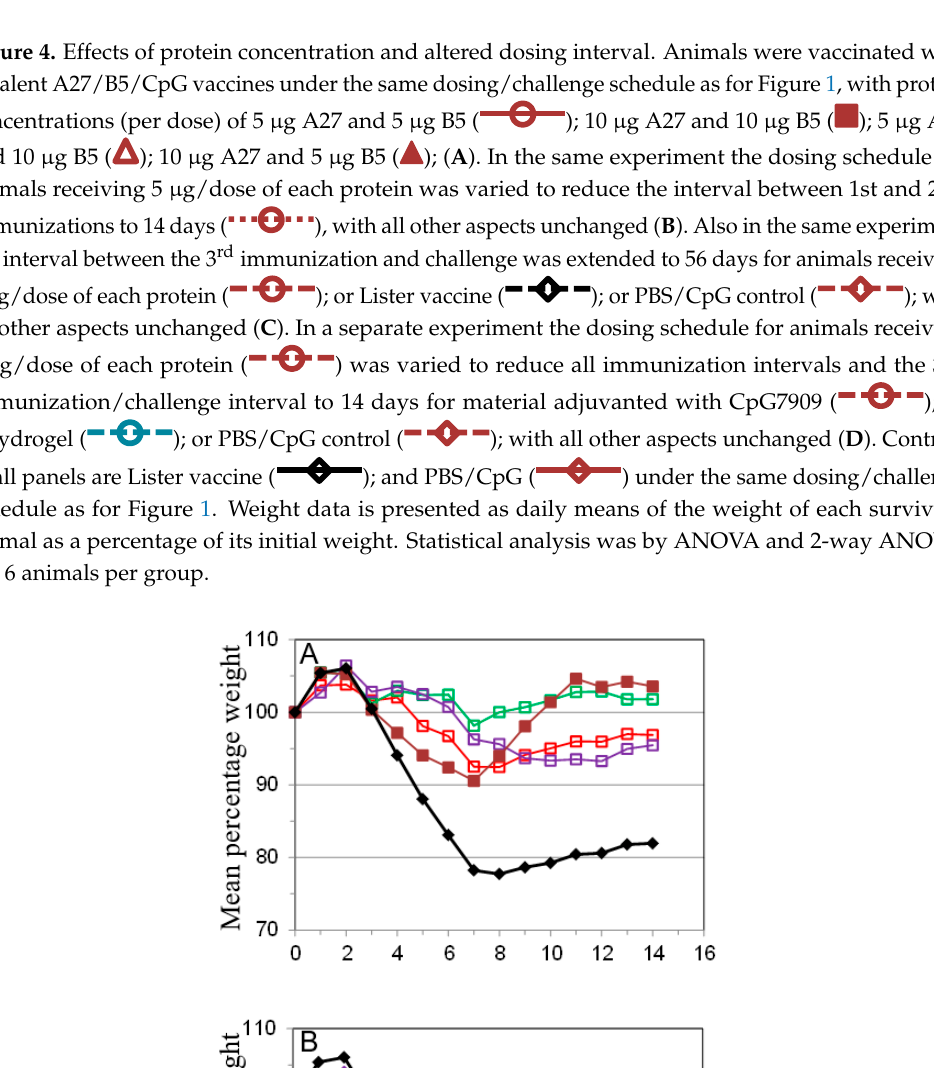
Figure 5. Effects of T cell subset depletion. Animals were vaccinated with PBS ( ), or with divalent A27/B5/CpG ( A ) or Lister ( B ) vaccines under the same dosing/challenge schedule as for Figure 1, with protein concentrations (per dose) of 10 µg A27 and 10 µg B5. Animals were further treated with anti- CD4 ( , ); anti-CD8 ( , ); anti-CD4 and anti-CD8 ( , ); or non-relevant Mab ( , ) as described in material methods. Weight data is presented as daily means of the weight of each surviving animal as a percentage of its initial weight. Statistical analysis was by ANOVA and 2-way ANOVA. n = 6 animals per group.